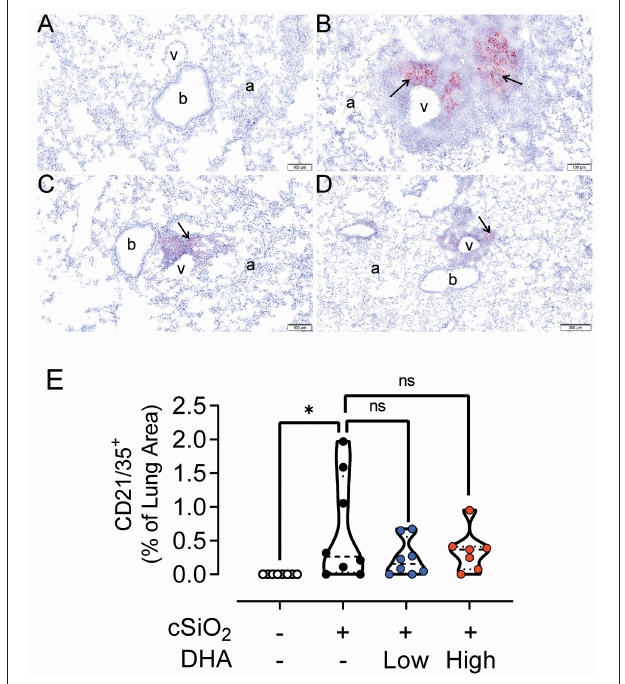
FIGURE 7 | High DHA diet reduces CD45R + B-cell infiltration in the lungs of cSiO 2 -treated mice. Light photomicrographs of lung tissue sections immunohistochemically stained for CD45R + B cells (arrows) from mice fed control diet and intranasally instilled with saline vehicle (Veh/CON, A ), fed control diet and intranasally instilled with cSiO 2 (cSiO 2 /CON, B ), fed 0.4 % DHA diet starting one week after the end of the intranasal cSiO 2 instillations (cSiO 2 /low DHA, C ), or fed the 1.0% DHA diet starting one week after the end of the intranasal cSiO 2 instillations (cSiO 2 /high DHA, D ). Marked perivascular and peribronchiolar B lymphoid cell accumulations (arrows) in lung of cSiO 2 /CON mouse. Moderate, minimal and no accumulations of B lymphoid cells around blood vessels (v) and bronchioles (b) in cSiO 2 /low DHA (C) , cSiO 2 /high DHA (D) , and Veh/CON ( A ) mice, respectively. a, alveolar parenchyma. (E) depicts percentage of CD45R + stained lung tissue. Statistical comparisons were performed between groups, as described in the Methods section. *** p ≤ 0.001, * p ≤ 0.05, ns = not significant.